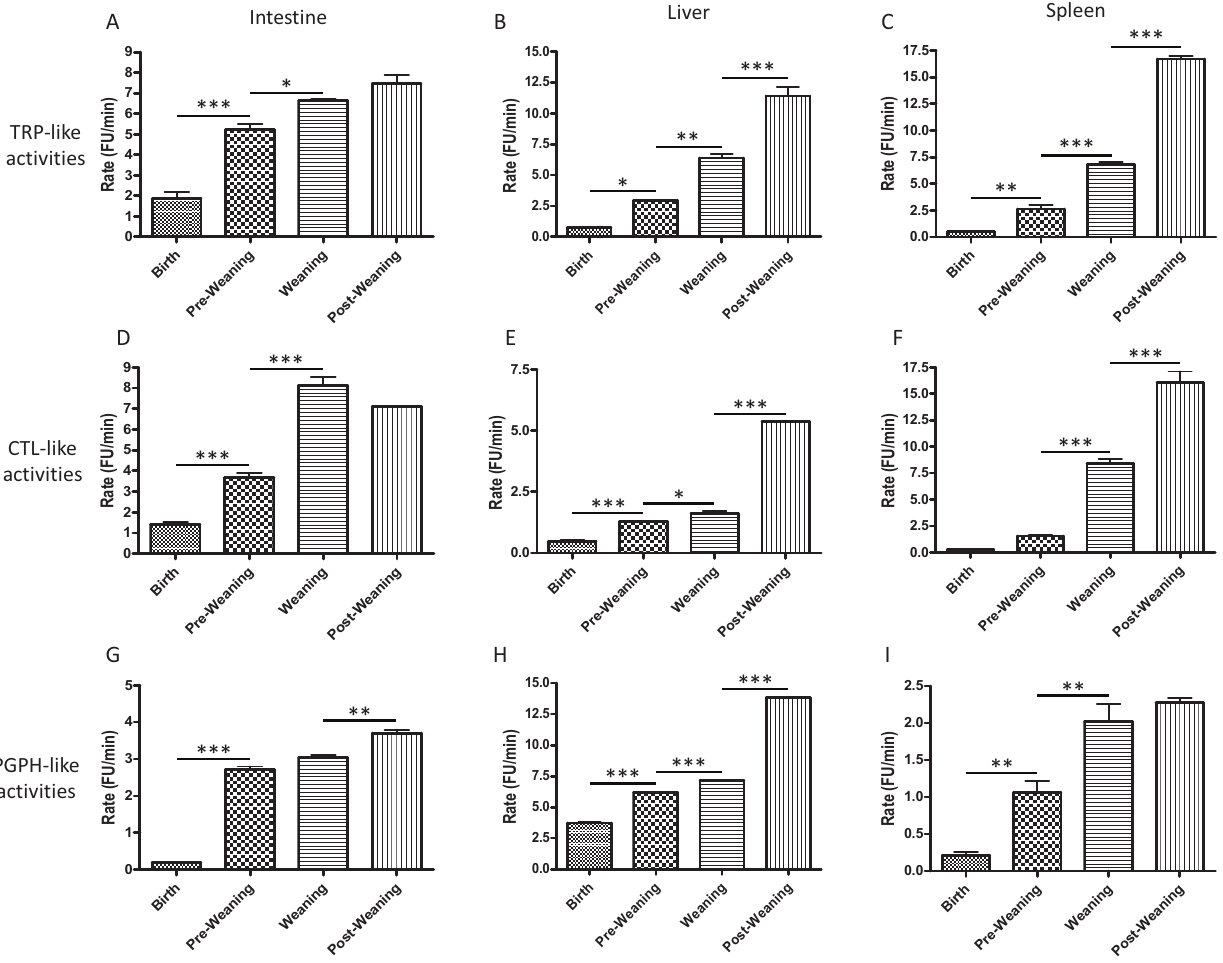
Figure 1. TRP- ( A , B , C ), CTL- ( D , E , F ), and PGPH-like ( G , H , I ) activities of 26S proteasomes isolated from intestine ( A , D , G ), liver ( B , E , H ) and spleen ( C , F , I ). Proteasomes were isolated using affinity purification at time points chosen from birth (0 days old, DO), pre-weaning (one week old, WO), weaning (3 WO), and post-weaning (5 WO) and assayed for catalytic activity as described in methods. 25 μg of proteasomes were used